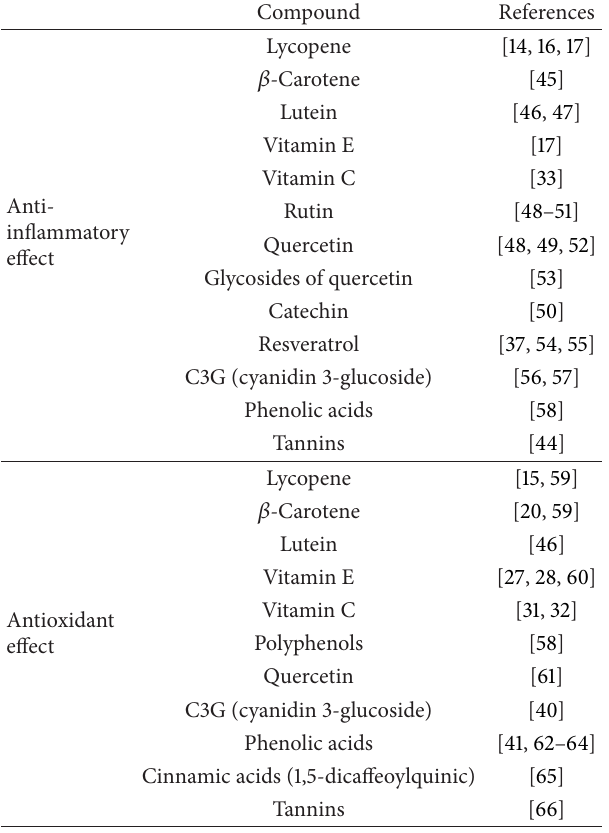
Table 2: Main anti-inflammatory and antioxidant effects of bioac- tive tomato